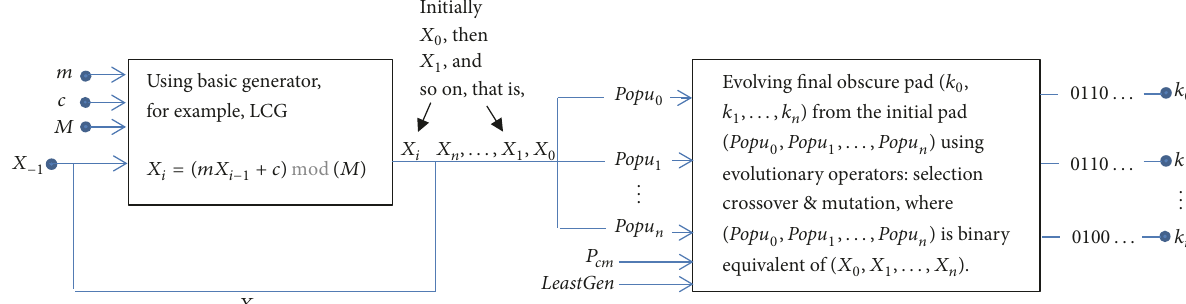
Figure 1: Block diagram of the proposed generator: